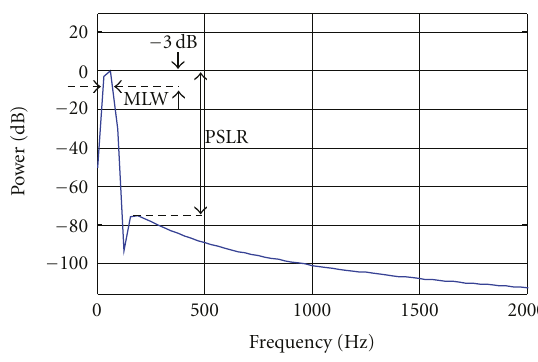
Figure 3: Performance measures used in the